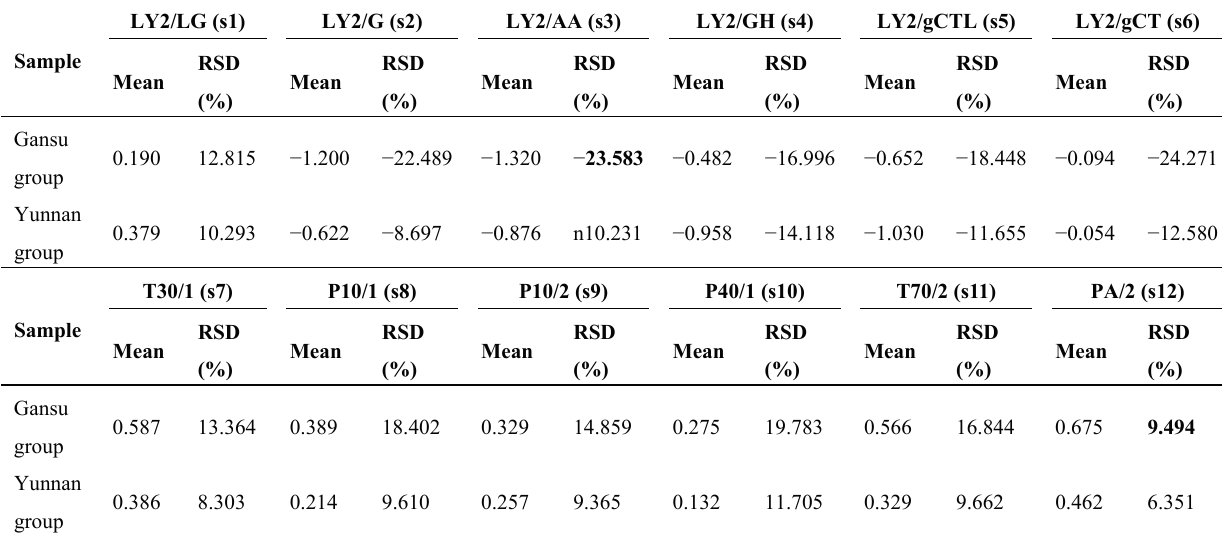
Table 6. The average value of the maximum responses of the